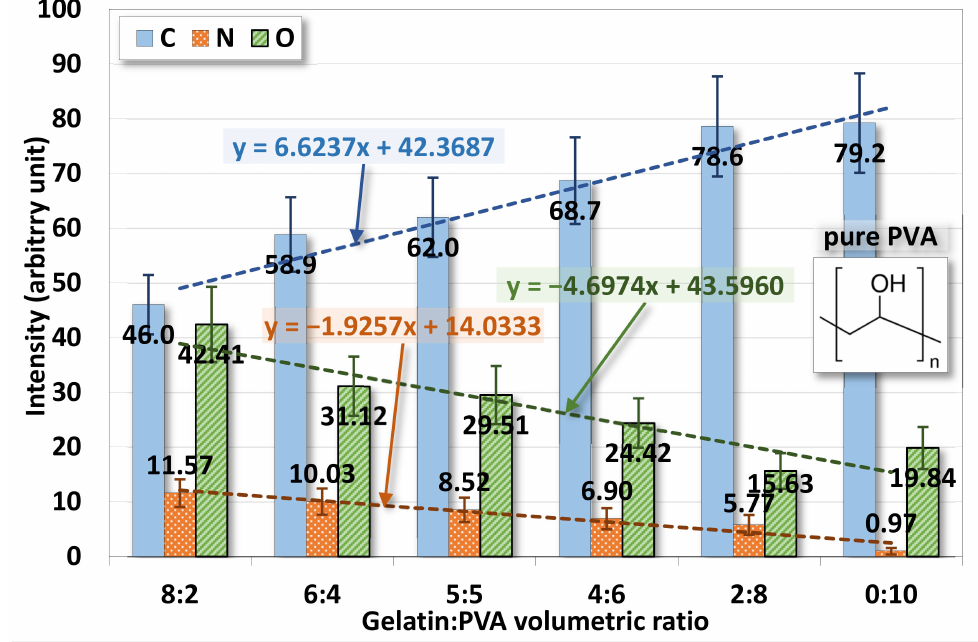
Figure 8. Variations of surface chemical elements from the EDS of electrospun gelatin/PVA mixed